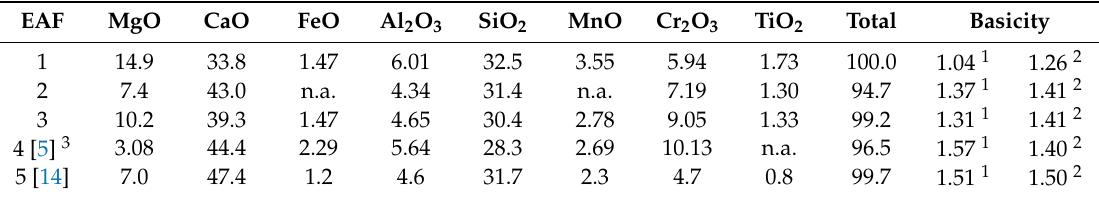
Table 1. Average slag compositions at the tapping stage of three EAFs for stainless steel production (in wt.%).